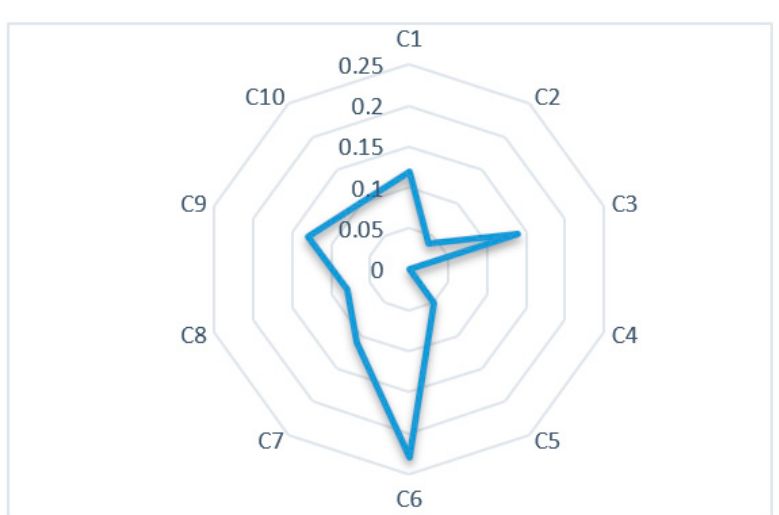
Figure 6. The weight of personnel selection criteria Table 17. Judgments matrix for alternatives.